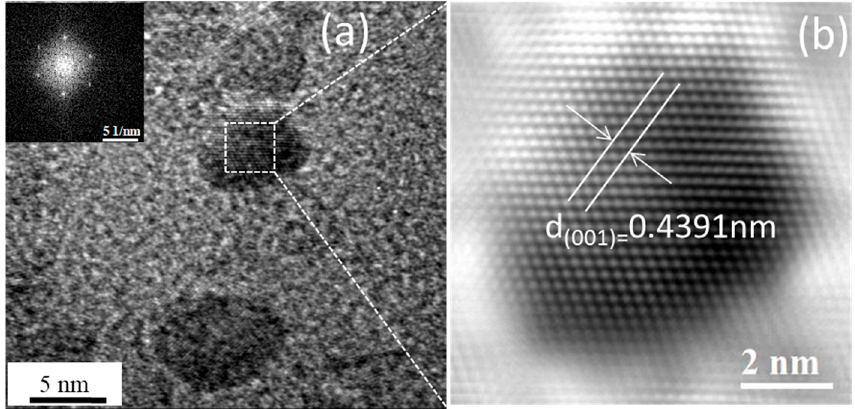
Figure 7. High-resolution image of a (Nb, Mo)C particle ( a ) and Inverse Fast Fourier Transform (IFFT) of area marked by a white-line frame on the this carbide particle ( b ). The precipitates electrolytically extracted from four different specimens by means of PCPA were confirmed with XRD diffraction spectrum, as shown in Figure 8, from which it can be seen that the precipitates are mainly composed of Fe 3 C and Nb carbides. There is only a weaker peak of TiN because of the small content of Ti and N in steels.